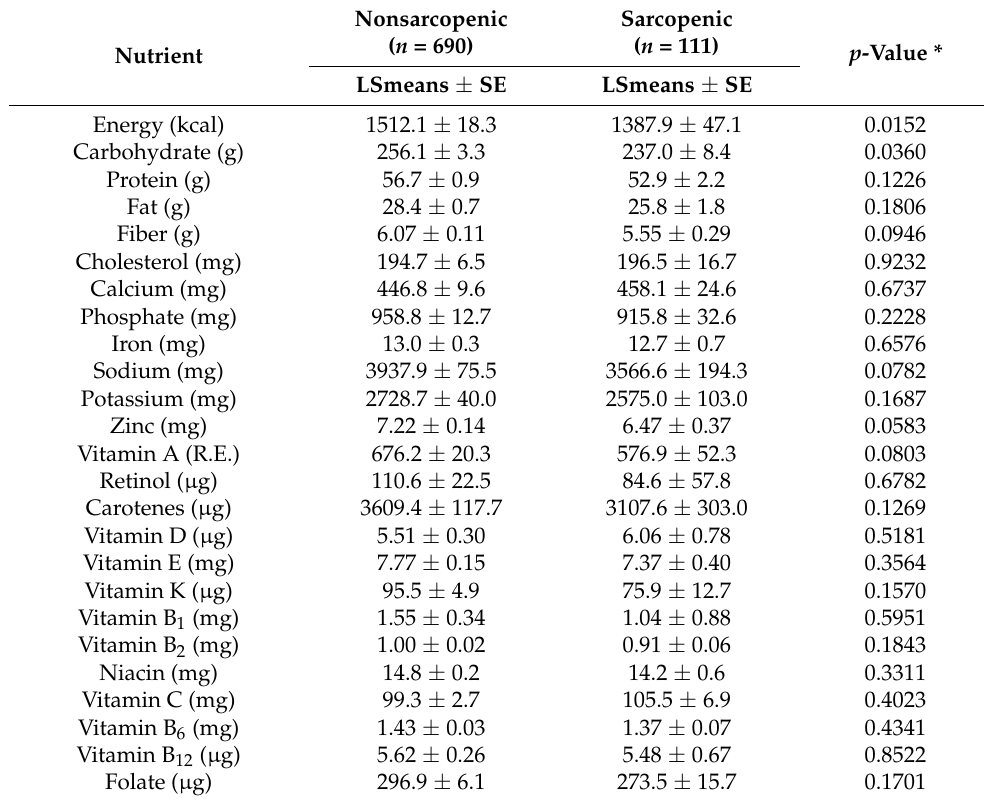
Table 3. Comparison of nutrient